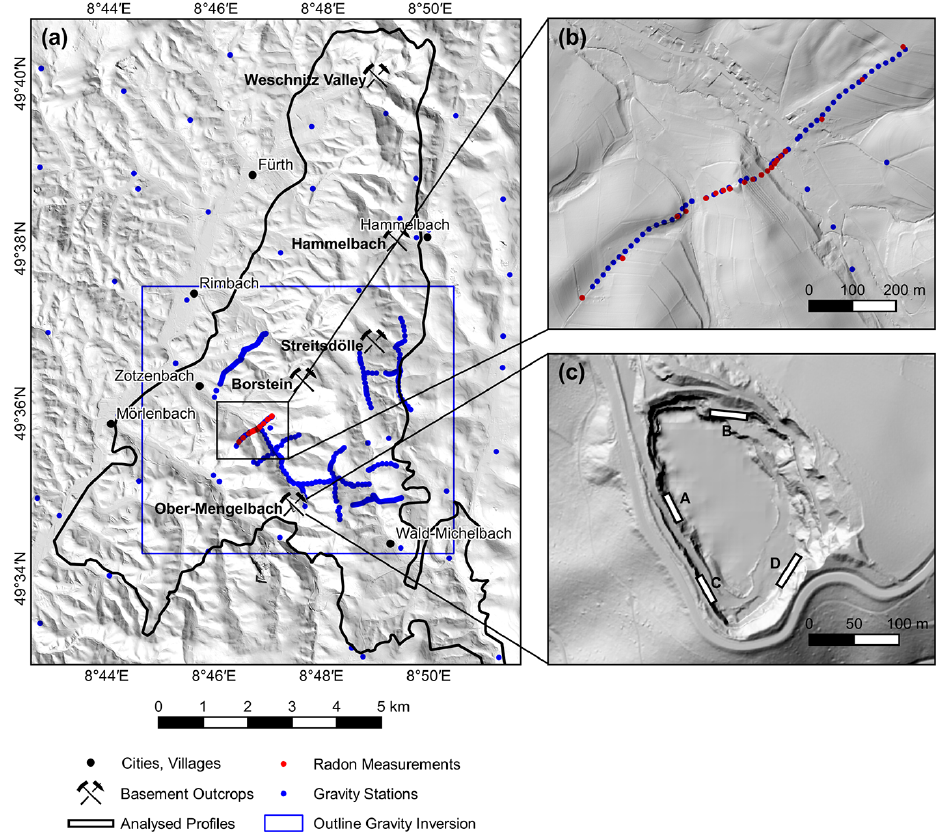
Figure 2. Overview map of the surveys conducted in the Tromm Granite: (a) locations of structural and geophysical data acquisitions; (b) detailed view of the combined gravity and radon profile; (c) detailed view of the quarry in Ober-Mengelbach with the locations of 2D profiles, which have been manually interpreted. The digital elevation model was provided by the HVBG (Hessische Verwaltung für Bodenmanagement und